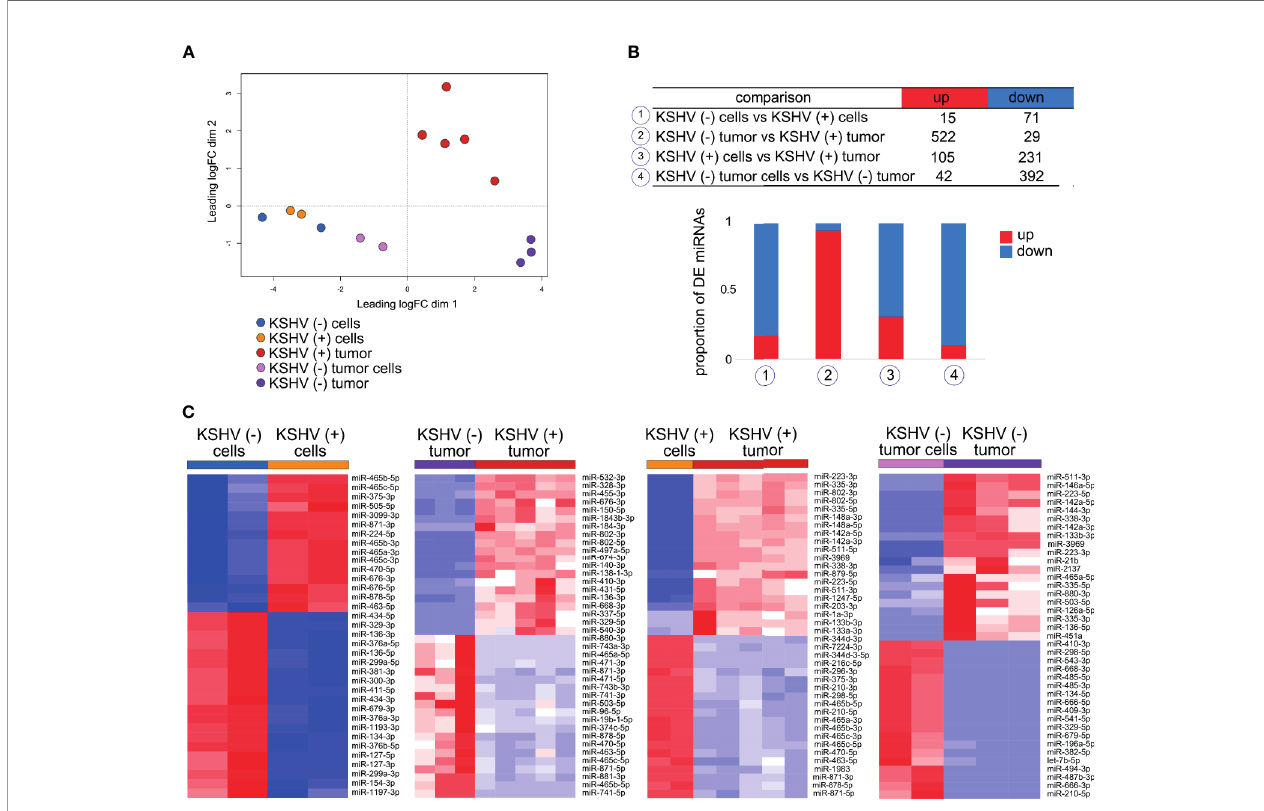
FIGURE 4 | Host miRNAs expression. (A) Multidimensional scaling plot of the host miRNAs showing the distance of each sample from each other determined by their leading logFC. (B) Number of DE miRNAs in key biological comparisons that were detected by small RNA-sequencing analysis of: two KSHV (+) cells, two KSHV ( − ) cells, six KSHV (+) tumors, two KSHV ( − ) tumor cells and three KSHV ( − ) tumors. (C) Heat maps for fold change expression of host miRNAs based on analysis of small RNA sequencing data, only top 20 upregulated and top 20 downregulated DE host miRNAs are shown in each